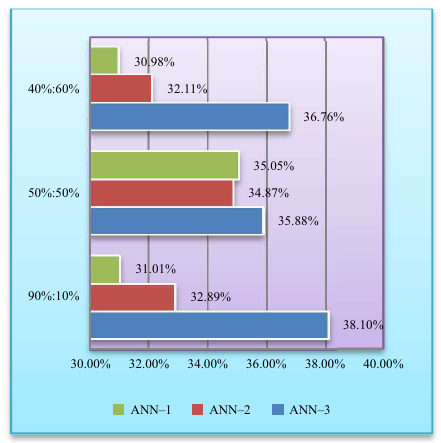
Fig. 4. Average results of type–II error on different Tr/Te sets*